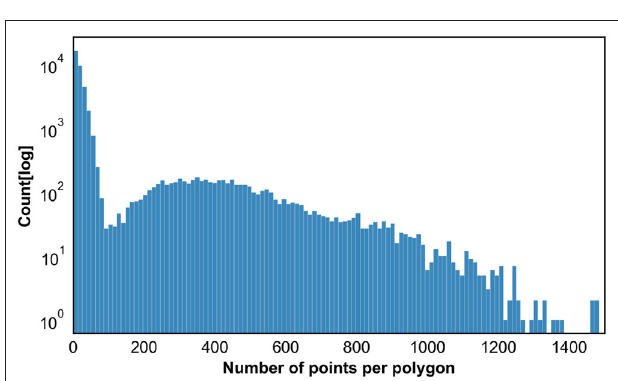
FIGURE 6 | Distribution of the Number of Points across all the polygons (instance segmentation annotations). For the sake of clarity, this plot excludes a small fraction of the annotations with number of points higher than